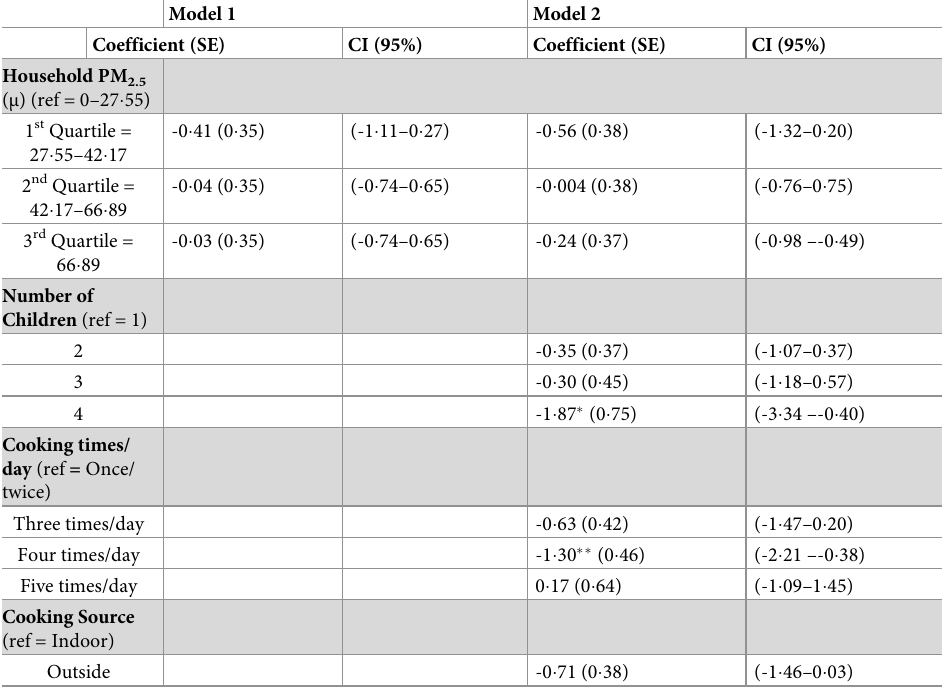
Table 4. Univariate and multivariate analyses of association between PM 2 � 5 exposure and